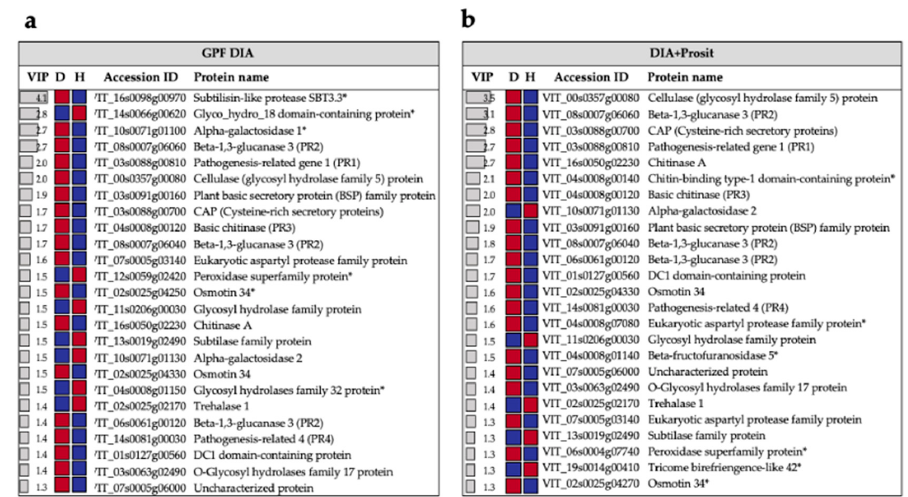
Figure 8. Top 25 V. vinifera proteins contributing to the variance between groups observed by PLS- DA. The plot shows the variable importance in projection (VIP) scores, and the colored boxes indicate the relative intensity of the corresponding protein in diseased (D) and healthy (H) plants detected by ( a ) GPF DIA and ( b ) DIA+Prosit. Red represents detection of high and blue, of low exclusive intensity. Proteins marked with an asterisk (*) are among the top 25 regardless of method. The common 139 proteins detected using both methods were used.